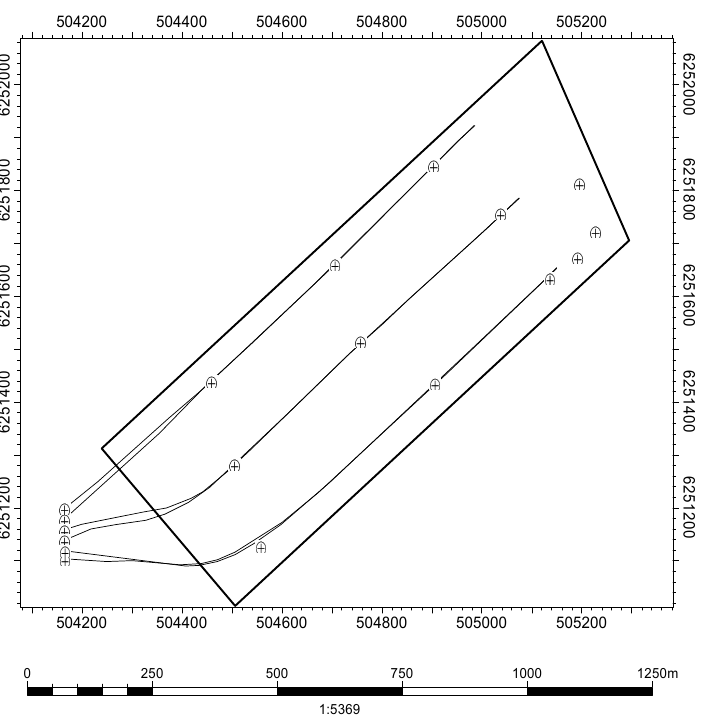
Figure 10. Study Area Map.